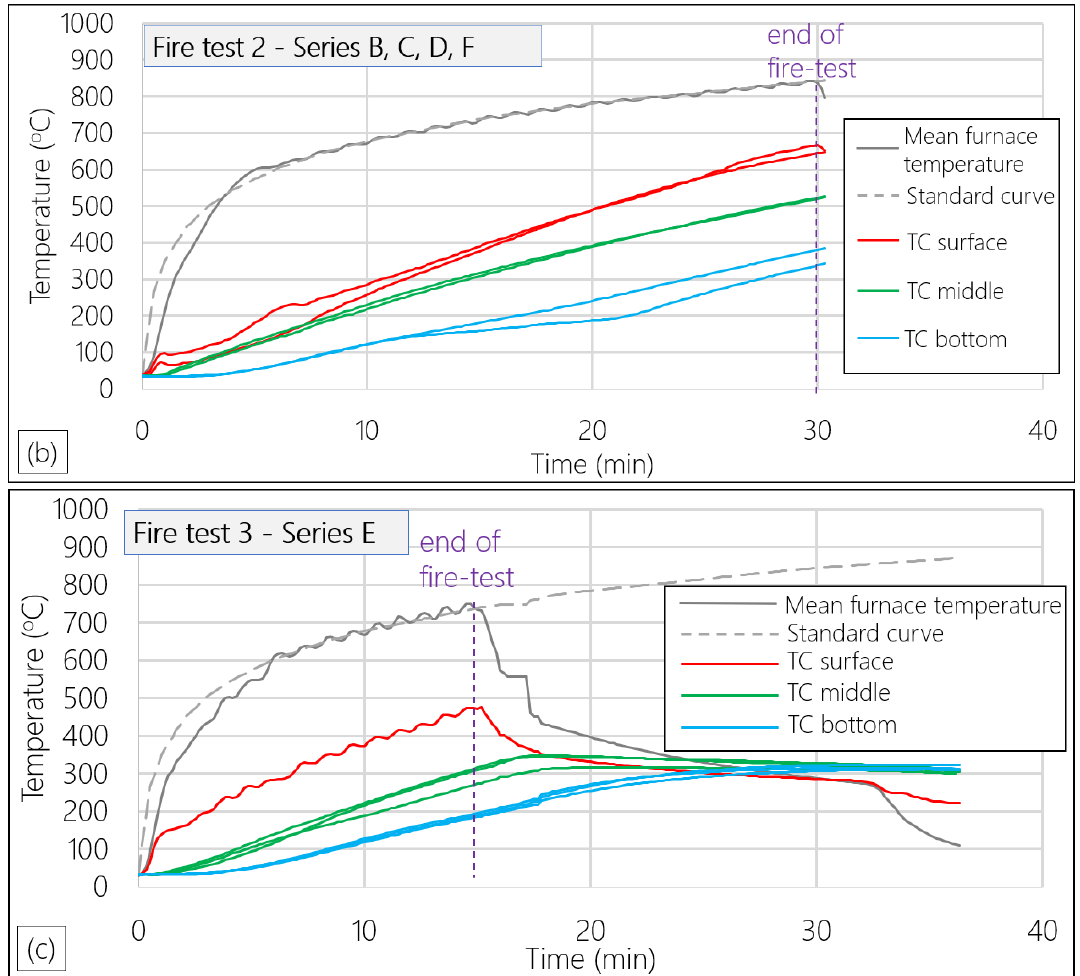
Figure 6. ( a ) Temperature measurements from fire test 1; ( b ) temperature measurements from fire test 2; ( c ) temperature measurements from fire test 3.